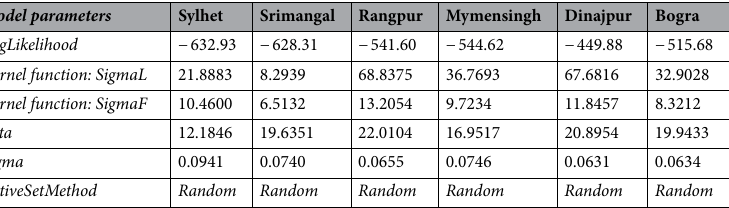
Table 4. Optimized parameters of EGPR models for six target stations without any lead. SigmaL length scale for predictors, SigmaF signal standard deviation, Beta initial value of coefficients, Sigma initial value for the noise standard deviation of the Gaussian process model, ActiveSetMethod active set selection method, LogLikelihood the natural logarithm of the likelihood.